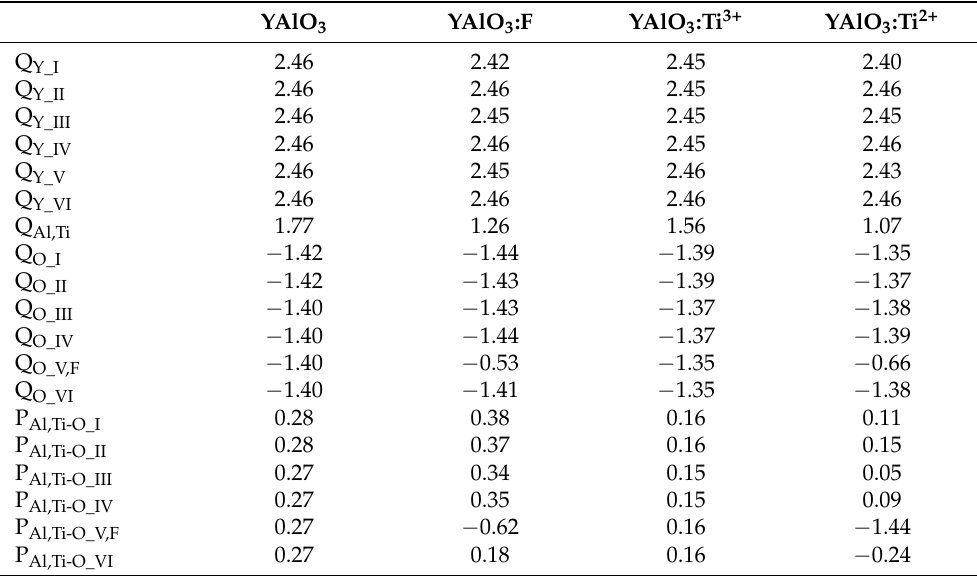
Table 4. Mulliken population analysis of pristine and Ti-doped YAlO 3 crystals in orthorhombically distorted perovskite structure. Q is Mulliken effective charge in e, bond populations P are in e. Negative bond population means electronic repulsion. For atomic notations please see Figure 2. YAlO 3 YAlO 3 :F YAlO 3 :Ti